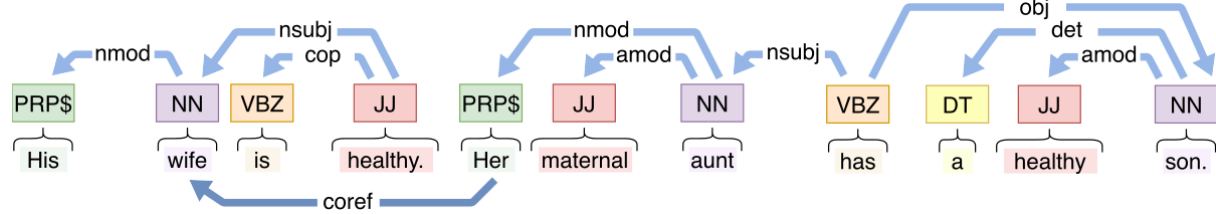
Figure 1. Illustrative example of dependency parsing and coreference resolution from Stanford CoreNLP. amod: adjectival modifier; cop: copula; coref: coreference; det: determiner; DT: determiner; JJ: adjective; nmod: nominal modifier; NN: noun; nsubj: nominal subject, obj: object; PRP$: possessive pronoun; VBZ: verb third person singular